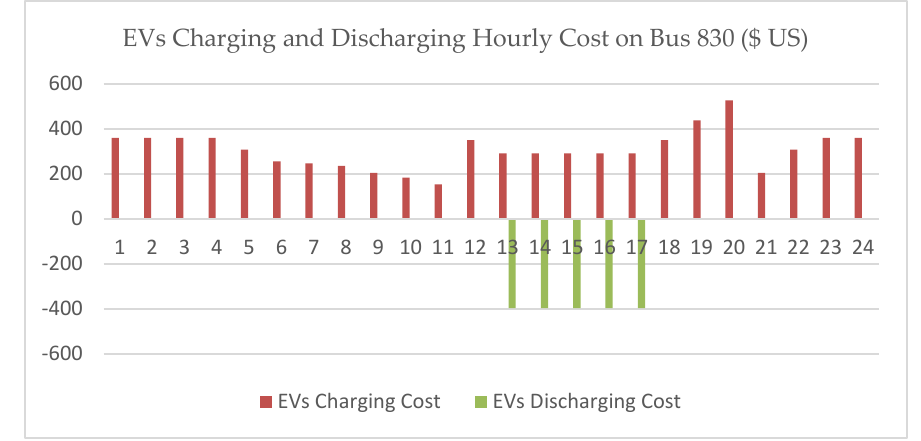
Figure 12 . Case 3 EVs Charging and Discharging Cost on Bus 830. Figure 12. Case 3 EVs Charging and Discharging Cost on Bus 830.